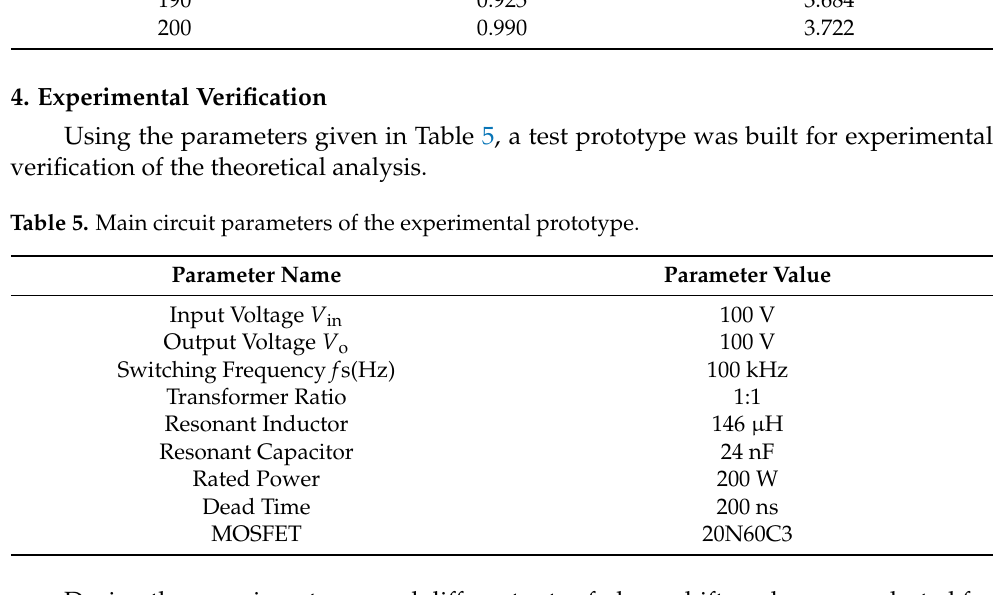
Table 4. Output voltage 100 V output power 100 W–200 W change optimal phase-shift angle com- bination table.